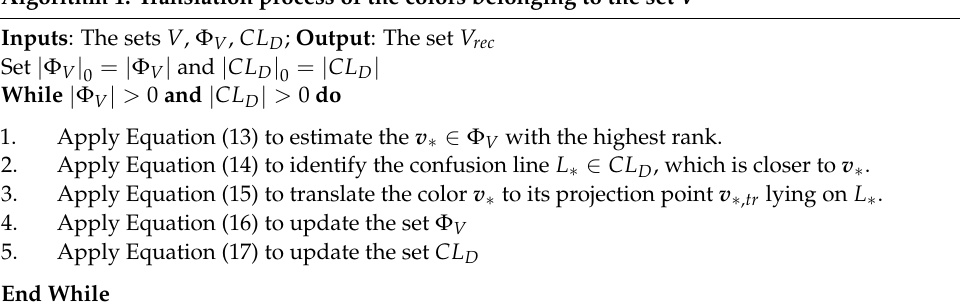
Algorithm 1: Translation process of the colors belonging to the set